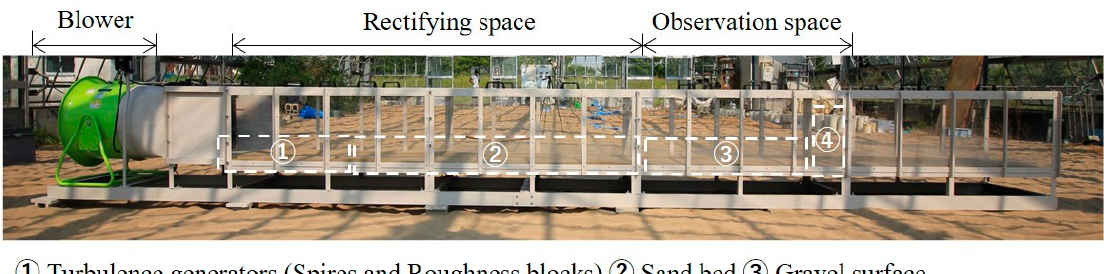
Figure 1. Photograph of the wind tunnel used in this study.